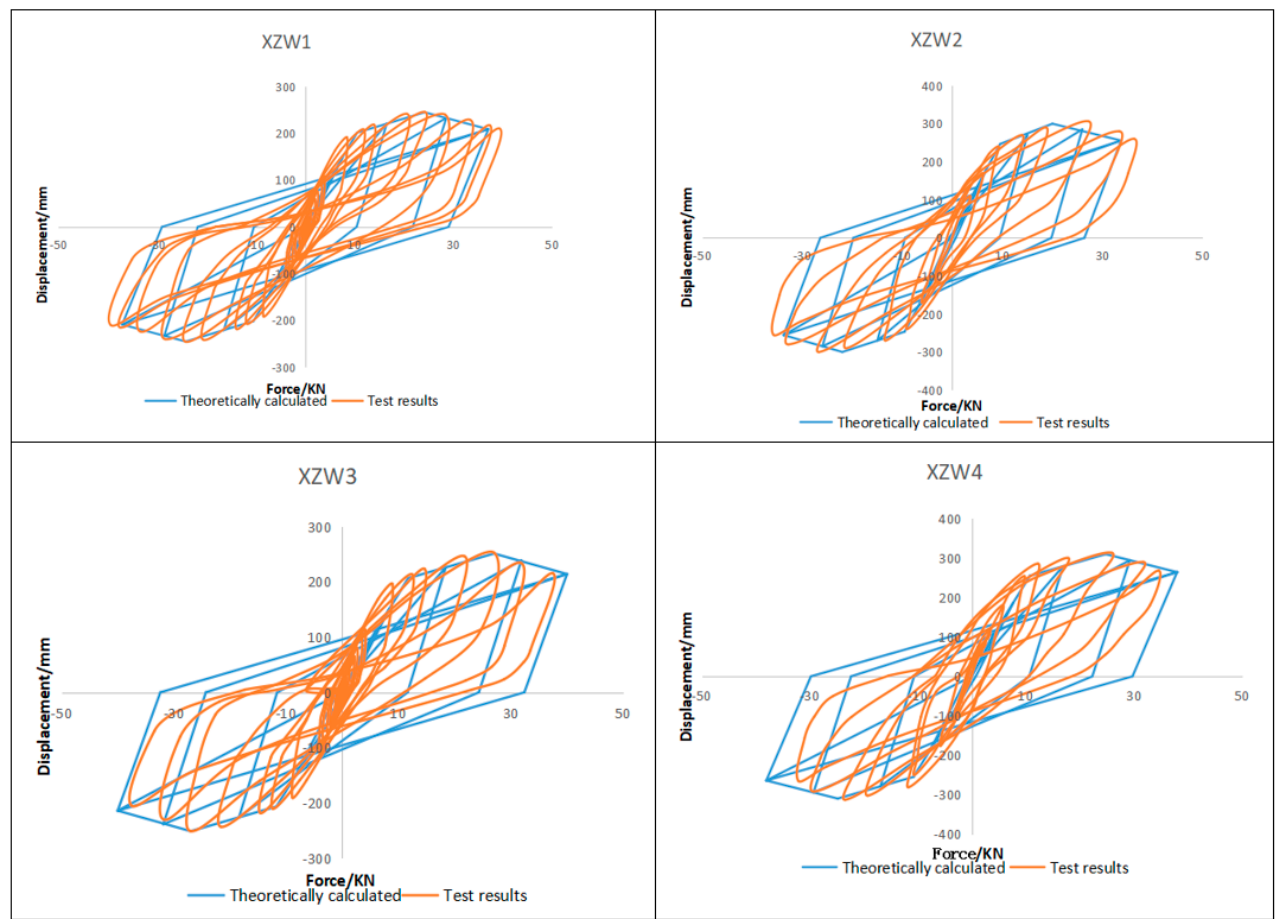
Figure 14. Comparison between the theoretical and experimental hysteretic curves of each specimen.